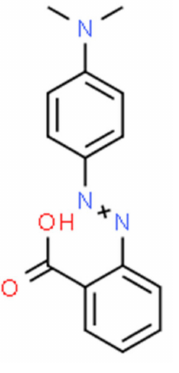
Figure 1. Chemical structure of Methyl